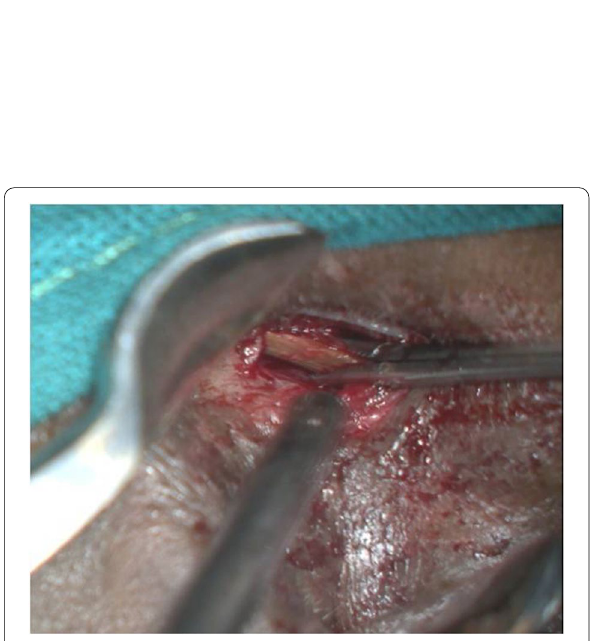
Fig. 3 Wooden stick encapsulated within the granulation tissue Fig. 4 Wooden stick of 2 cm removed in